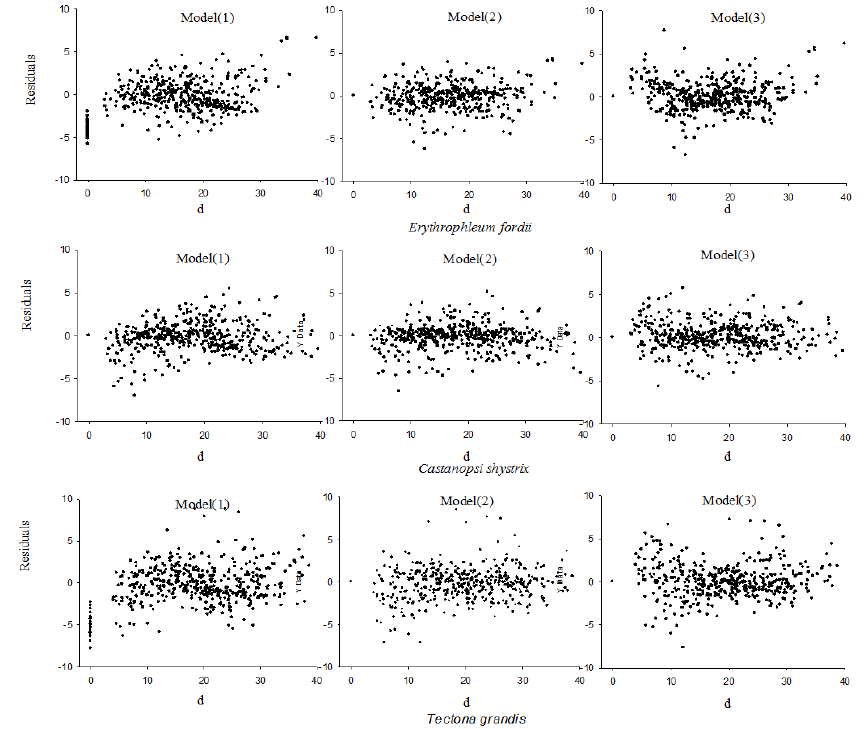
Figure 2. Residual distribution of estimated stem diameter for the three models of E. fordii , C. hystrix and T. grandis .